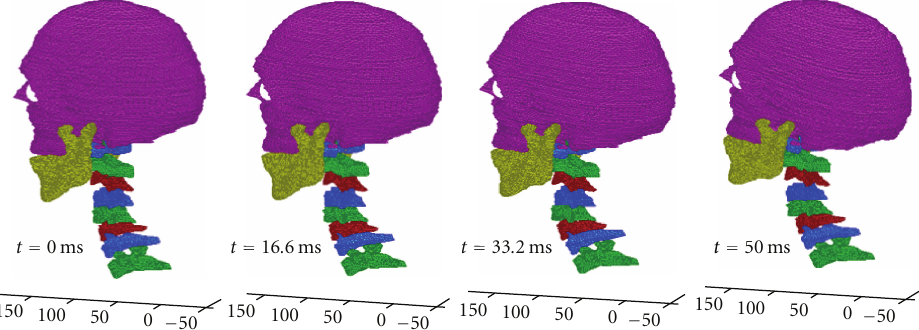
Figure 10: Images of the head-neck complex at di ff erent times during the simulation of the stationary primary positioning (times from left to right t = 0ms, t = 16 . 6ms, t = 33 . 2ms, and t = 50ms).